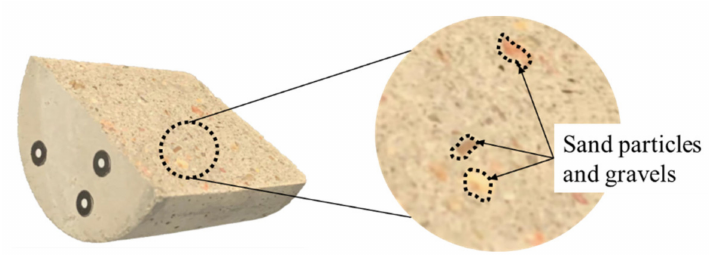
Figure 15. Illustration of sand particles and gravel embedded into the fracture